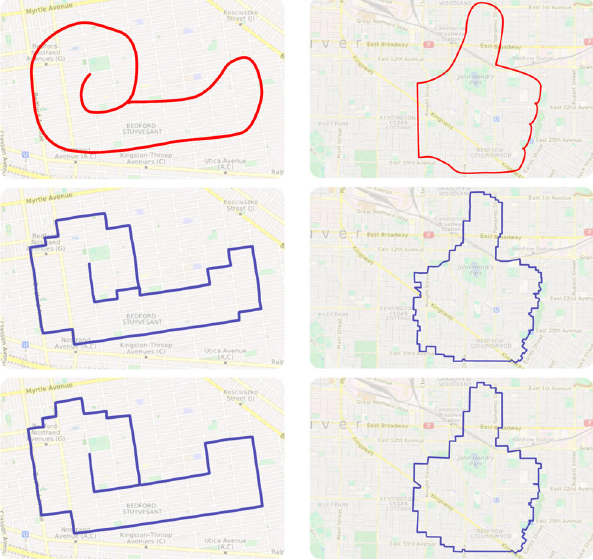
Fig. 10 Computing routes for a snail and a thumbs-up figure using our algorithm. Top: actual drawing of the figure. Middle: result using a heavily favored C 3 . Bottom: mainly basing our cost function on C 1 and C 2